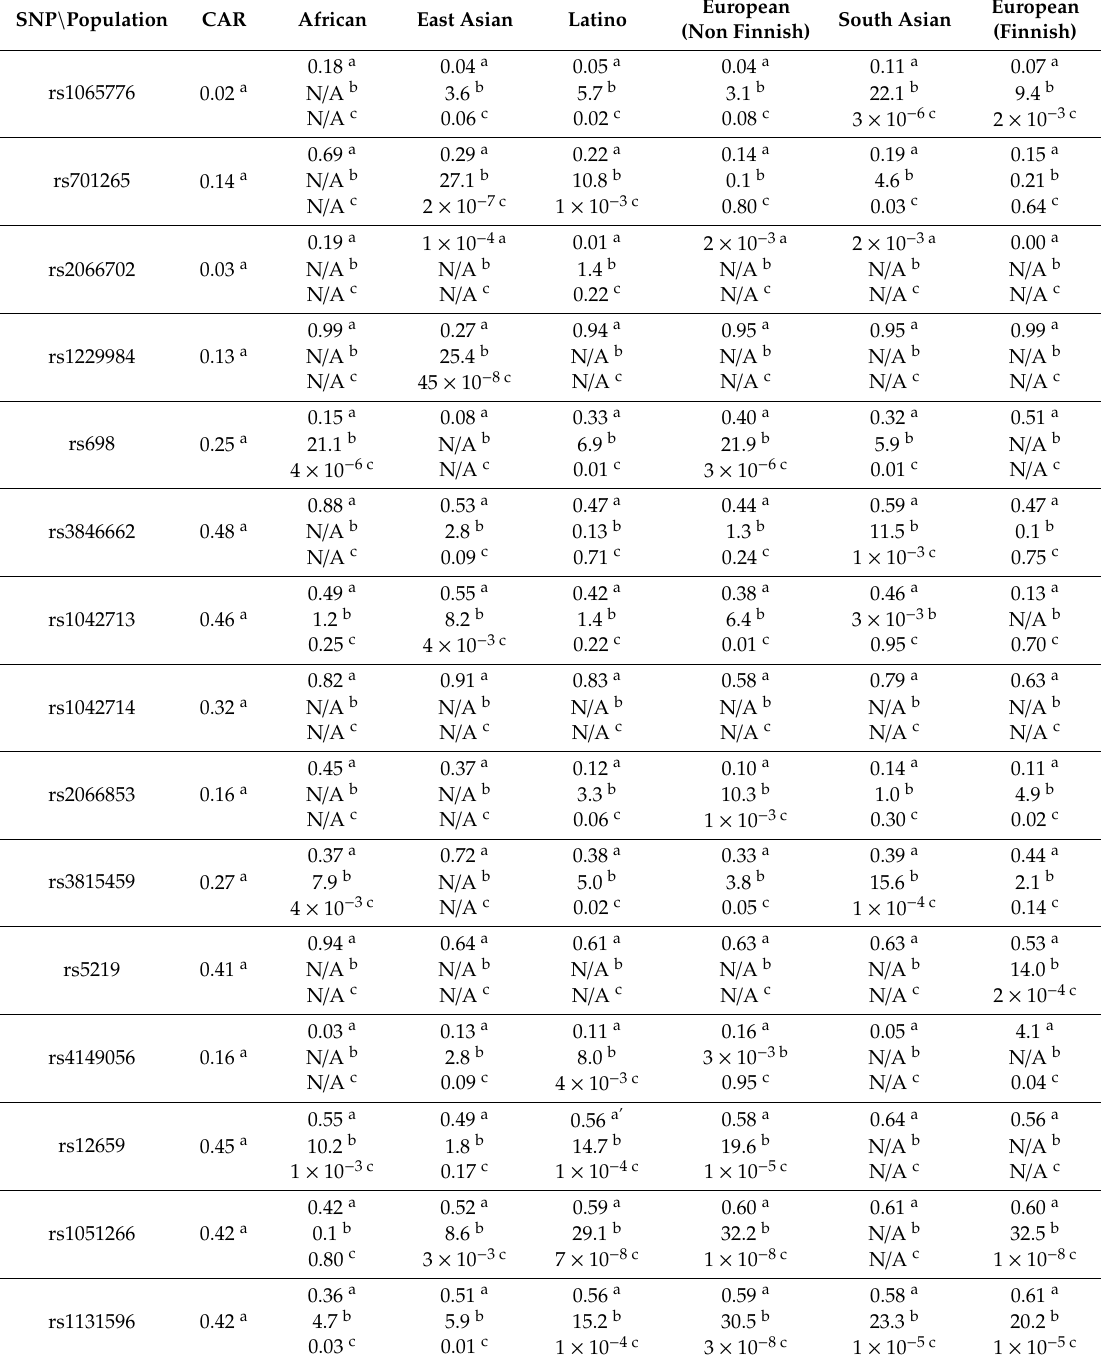
Table 4. Significant variants within the pharmacogenes in Circassian compared to six ExAC populations